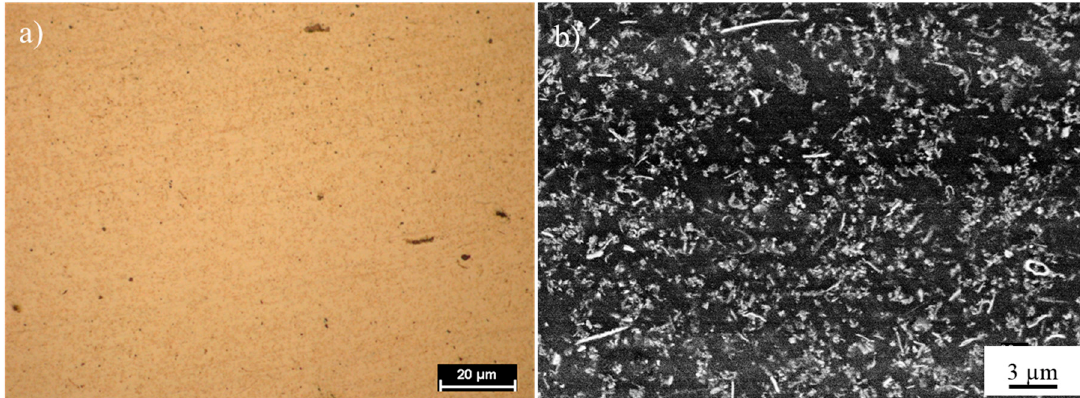
Figure 5. Microstructure parallel to the build direction (cross-section) in the central region of WE43 deposit: ( a ) OM and ( b ) SEM micrographs.